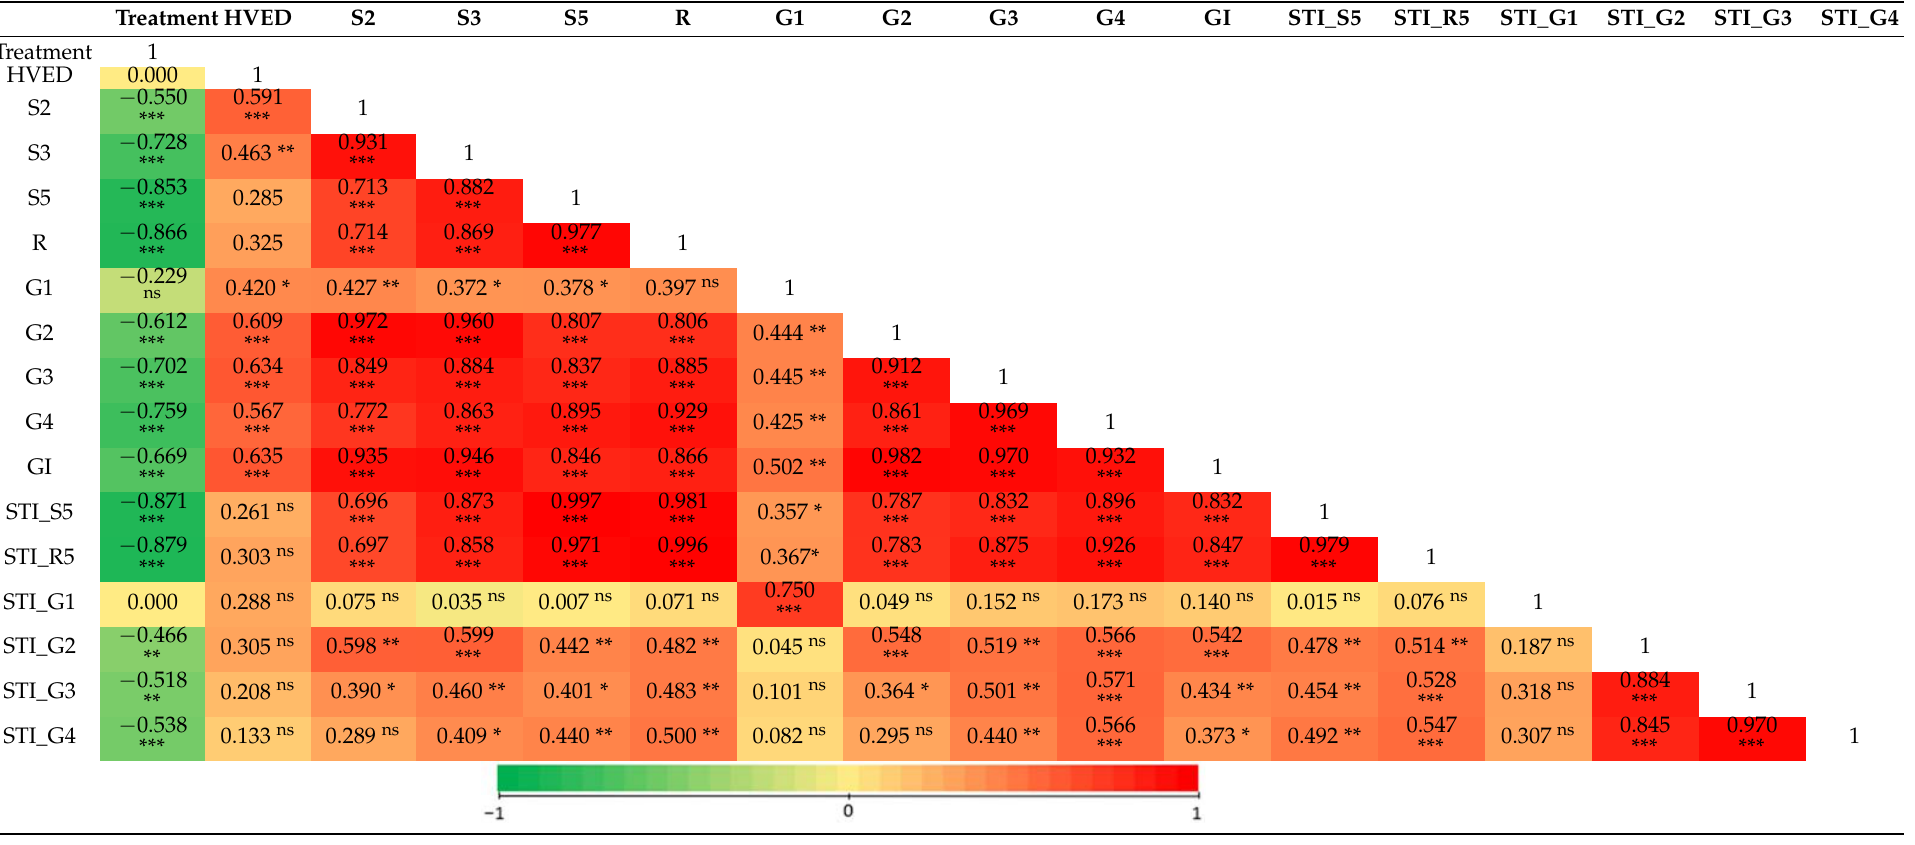
Table 9. Spearman’s correlation coefficients (r-values) among germination (G), shoot (S) and root (R) lengths, salt tolerance germination index (STI_G), and salt tolerance shoot (STI_S) and root (STI_R) indices under salt stress and high electrical discharge (HVED) pretreatment (*, **, ***, significant at 0.05, 0.01 and 0.001 level). Numbers next to capital letters represent the treatment